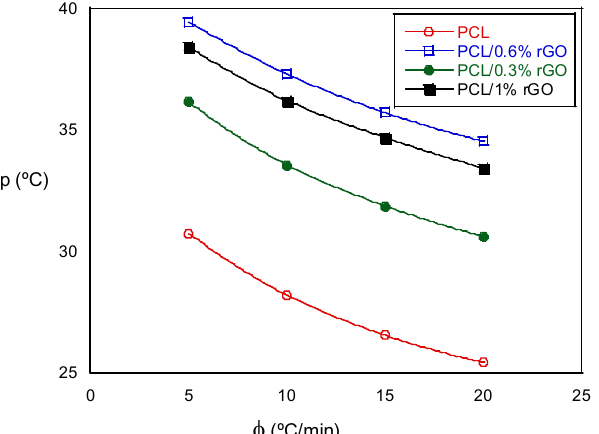
ate), although from the amorphous state.